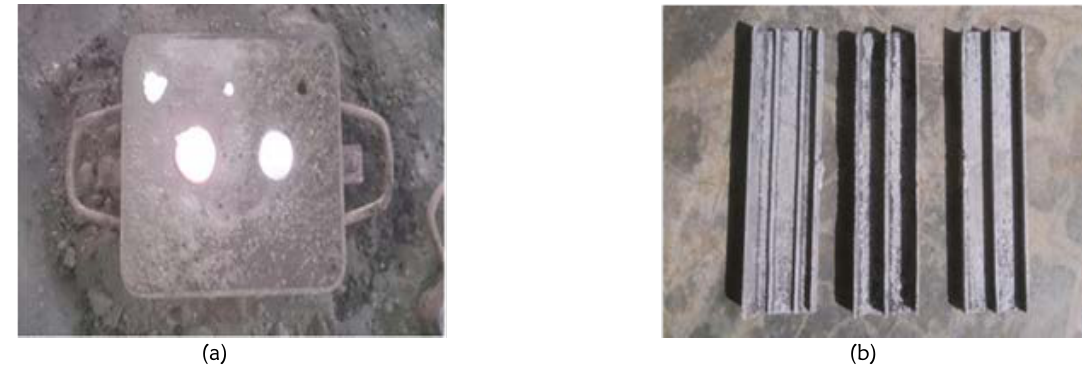
Figure 6: Fabrication of hybrid composites (a) stir sand mold casting process and (b) window frame after casting.